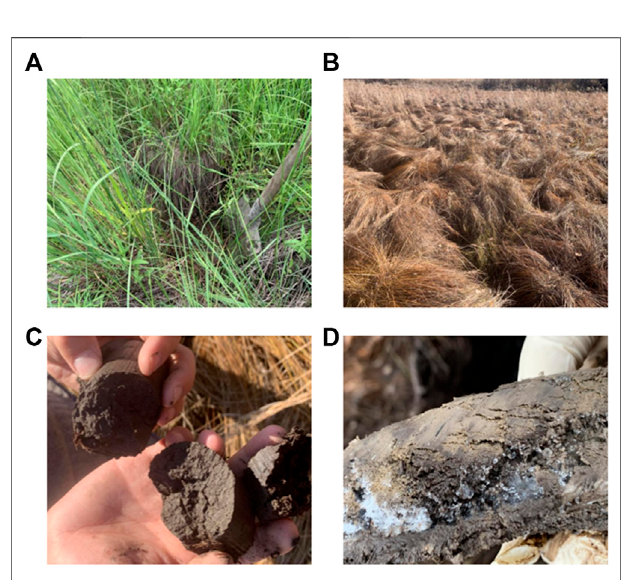
FIGURE2 | Vegetation on peatland (A,B) includingtower head, (C,D) at the bottom of the peatland active layer to the permafrost layer.